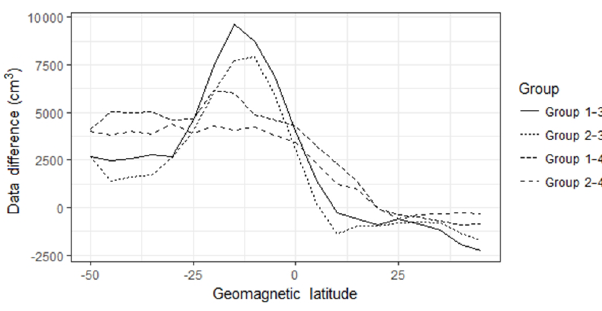
Figure 5. Variations in data differences with geomagnetic